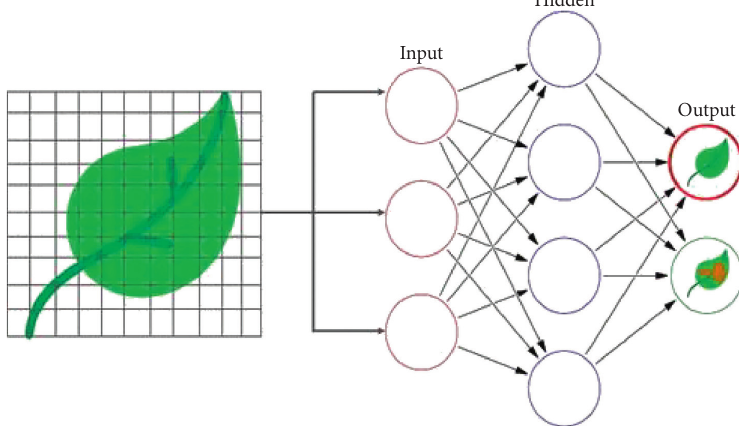
Figure 3: Artificial Neural Networks